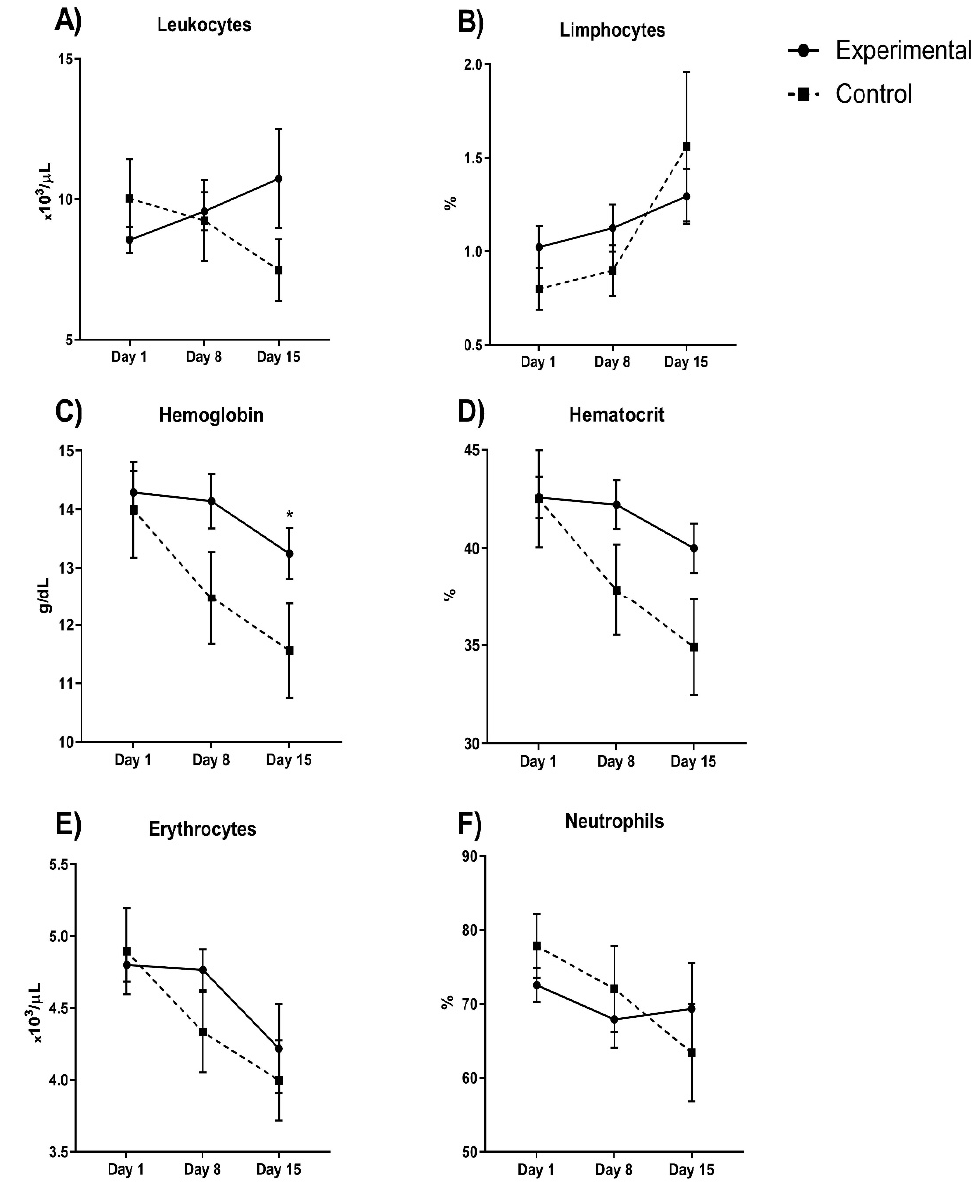
Figure 3. Blood count parameters between experimental and control group evaluated in COVID-19 patients ( A ) leukocytes; ( B ) lymphocytes; ( C ) hemoglobin; ( D ) hematocrit; ( E ) erythrocytes and ( F ) neutrophils during hospital stay days comparing both experimental vs. control group. Hemoglobin and hematocrit decreased in the experimental group by 5.6 and 9.7%, respectively ( p > 0.05). Cellular counting shows that erythrocyte and neutrophils decreased (44% and 10%, respectively), but not significantly, in the experimental group while leukocytes and lymphocytes increased, but not significantly (10.2% and 34.3%, respectively). * p < 0.05.